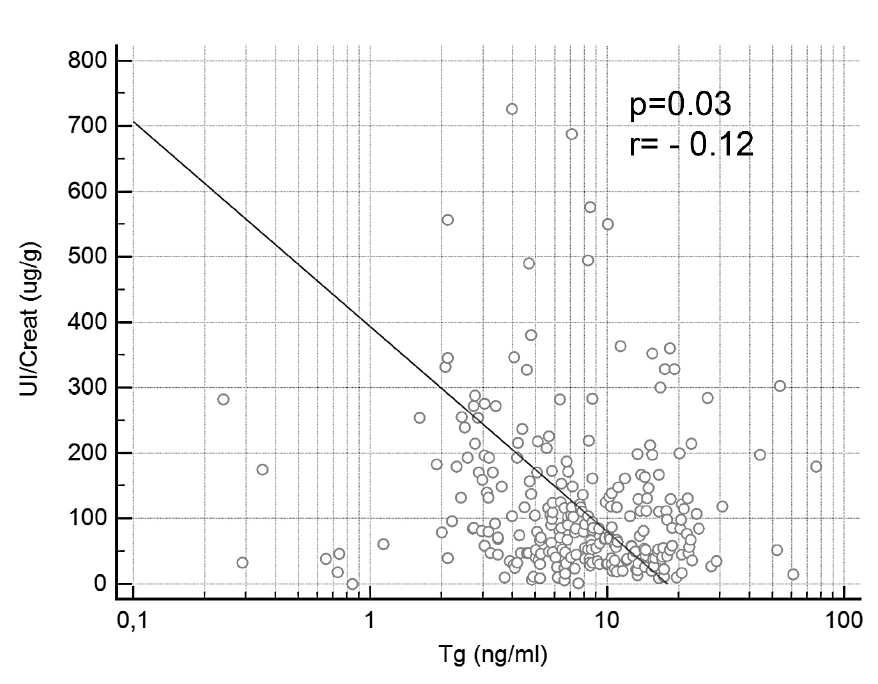
Figure 2. Correlation between iodine/creatinine ratio and thyroglobulin.